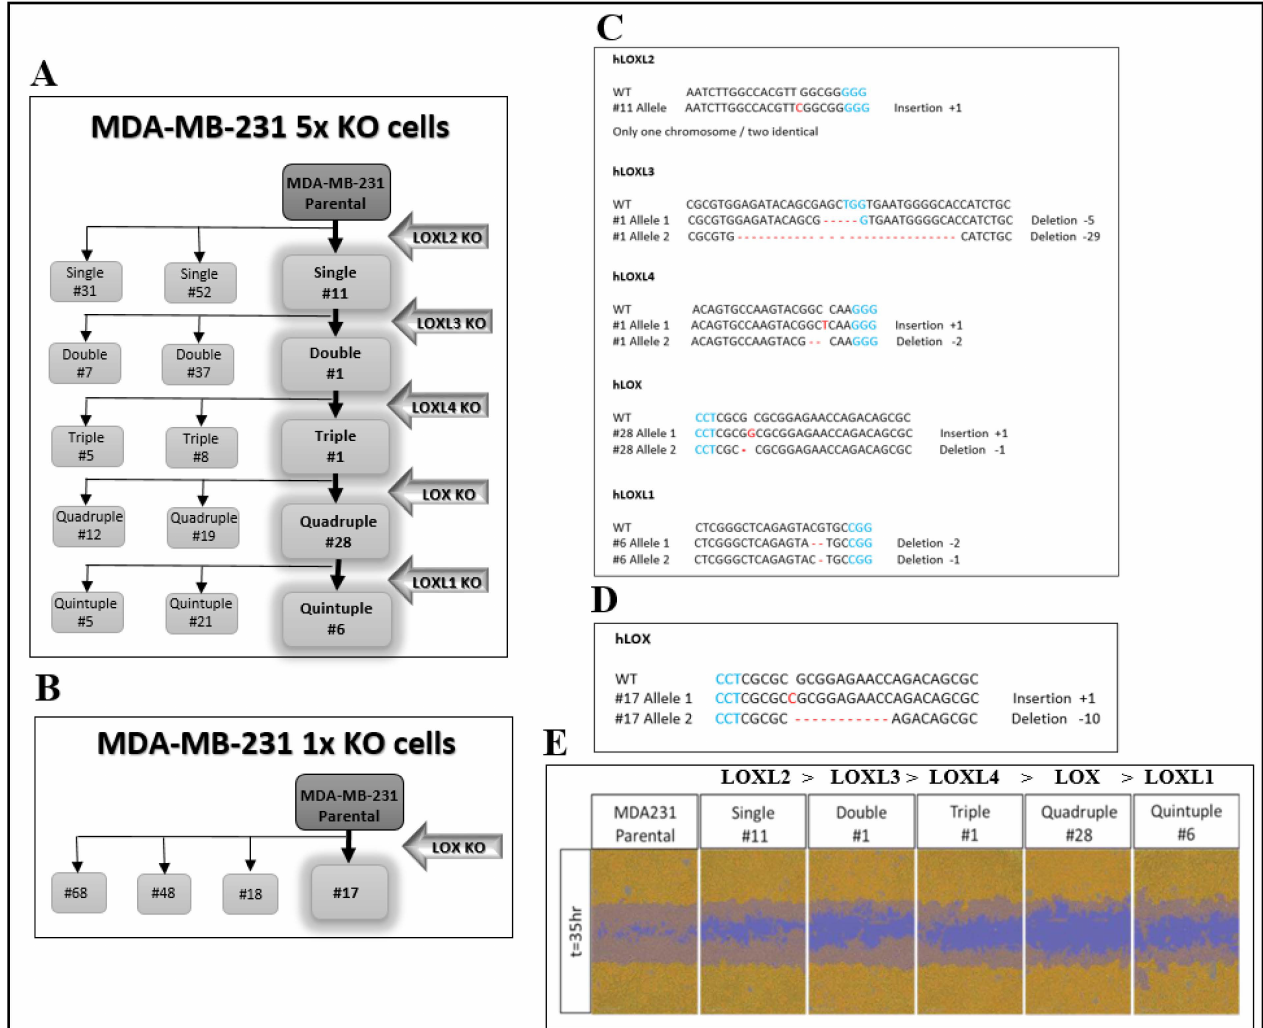
Figure 1. CRISPR/Cas9-mediated knock out of the five LOX family genes in MDA-MB-231 breast cancer cells. ( A ) A schematic of the sequential knock out of the lysyl-oxidase family genes that resulted in the generation of the 5 × knock-out clones (clones 5, 6 and 21). Knock out was performed using CRISPR/Cas9-mediated introduction of frame shift mutations into the first encoding exon of each gene. ( B ). The 1 × LOX single knock-out clones were generated similarly. ( C ) The frame shift mutations introduced into each of the alleles of the various lysyl-oxidase family genes in the generation of the clone 6 5 × knock-out cells. PAM sequences are highlighted in blue. Insertions or deletions are highlighted in red. ( D ) The frame shift mutations introduced into each of the LOX alleles of clone 17 1 × knock-out cells. ( E ) The invasiveness of MDA-MB-231 cells as well as cells from each of the intermediate sequential knock-out clones generated on the route to the final clone 6 5 × knock-out cells was evaluated as described in Materials and Methods. The assay was repeated independently three times with similar